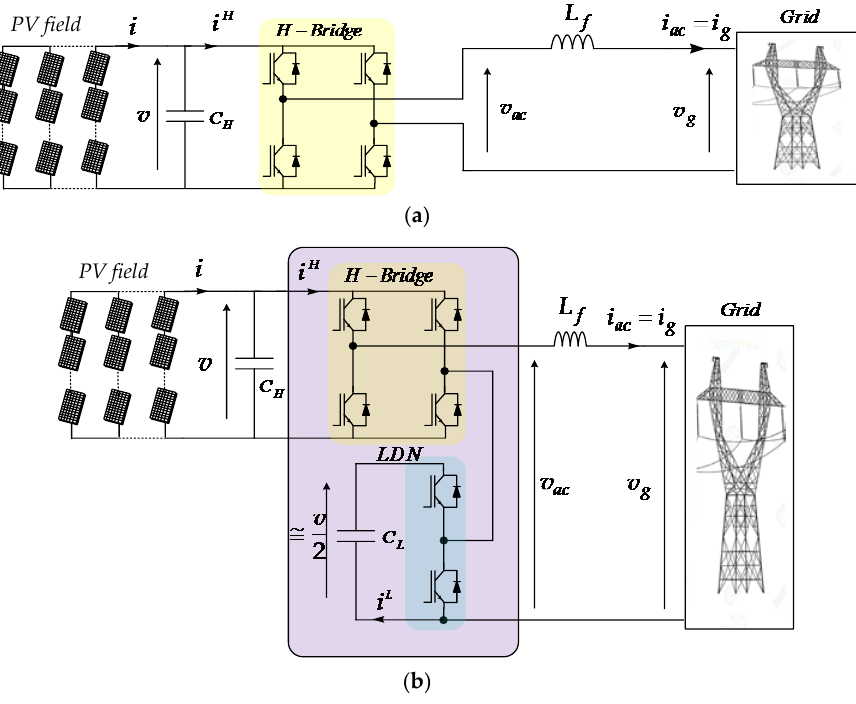
Figure 1. Single-phase single-stage photovoltaic (PV) generation system: ( a ) basic H-bridge configuration; ( b ) H-bridge plus level doubling network (LDN) multilevel configuration.